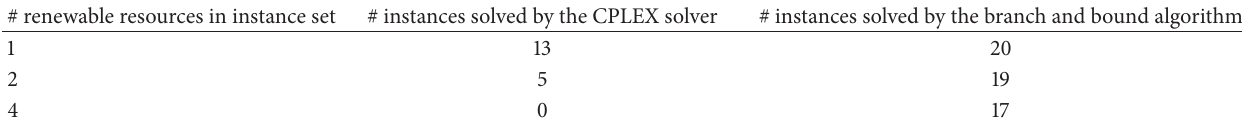
Table 2: Number of instances of each set of group II out of 20 solved to optimality in 10 seconds by the branch and bound algorithm and the CPLEX solver.